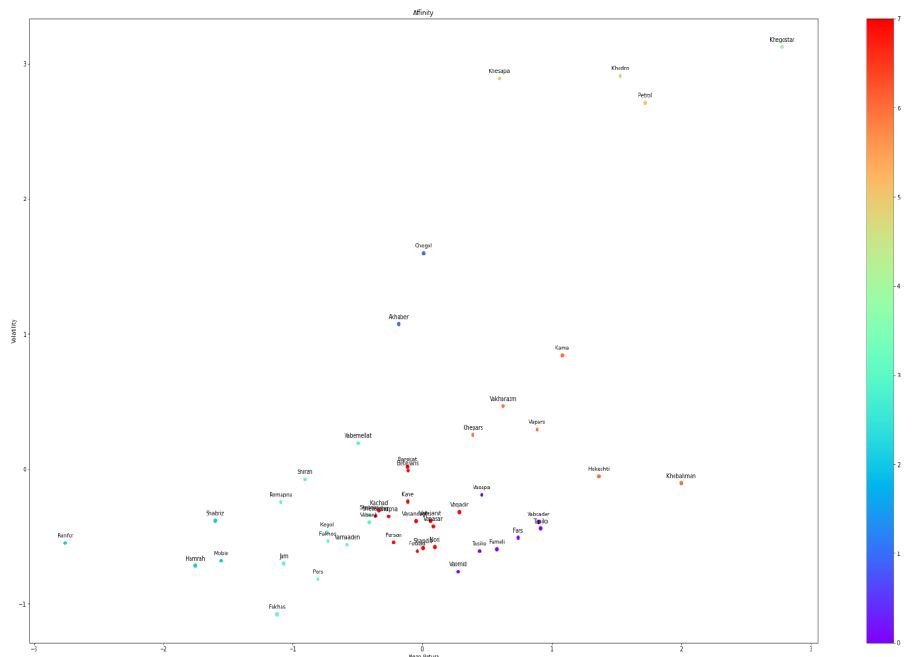
Figure 9. affinity propagation clustering